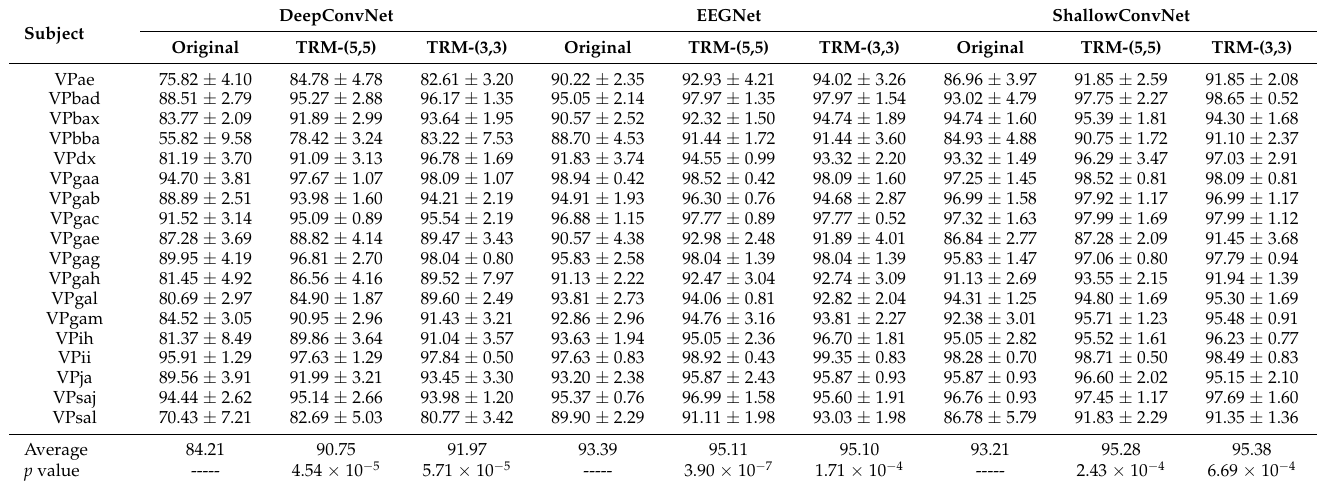
Table 1. Classification accuracies achieved by different algorithms on the